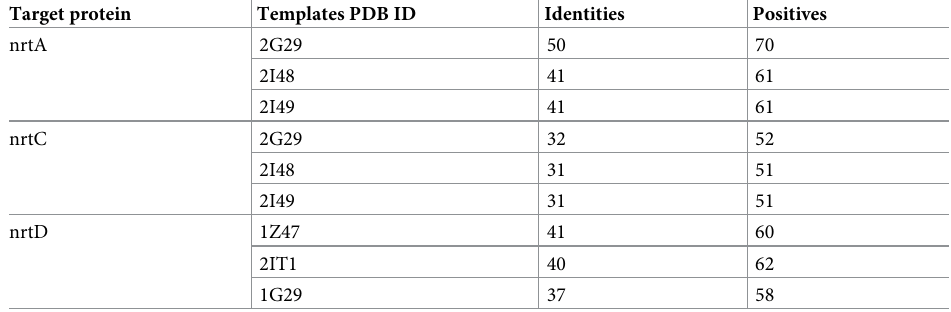
Table 1. Similarity between template and target proteins nrtACD of ABC-transporter based on identities and positives of model proteins.